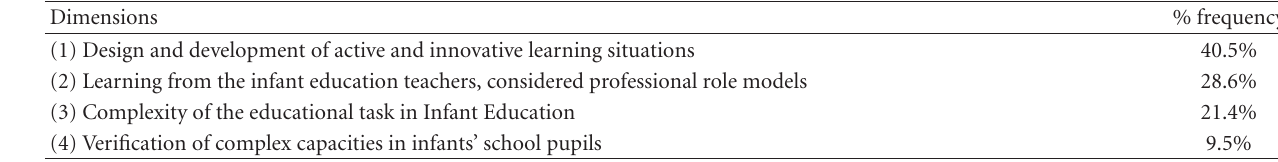
Table 3: Categorisation of group